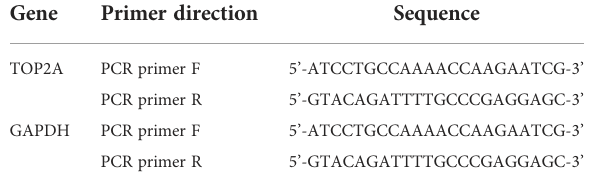
TABLE 3 Primers for